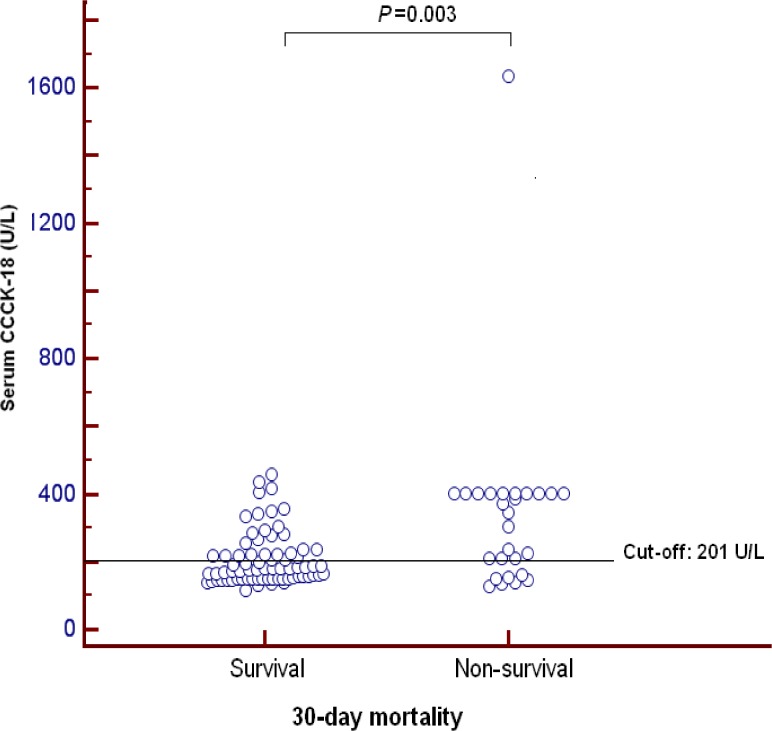
Dot-plot of serum caspase-cleaved cytokeratin (CCCK)-18 levels in 30-day surviving and non-surviving patients.